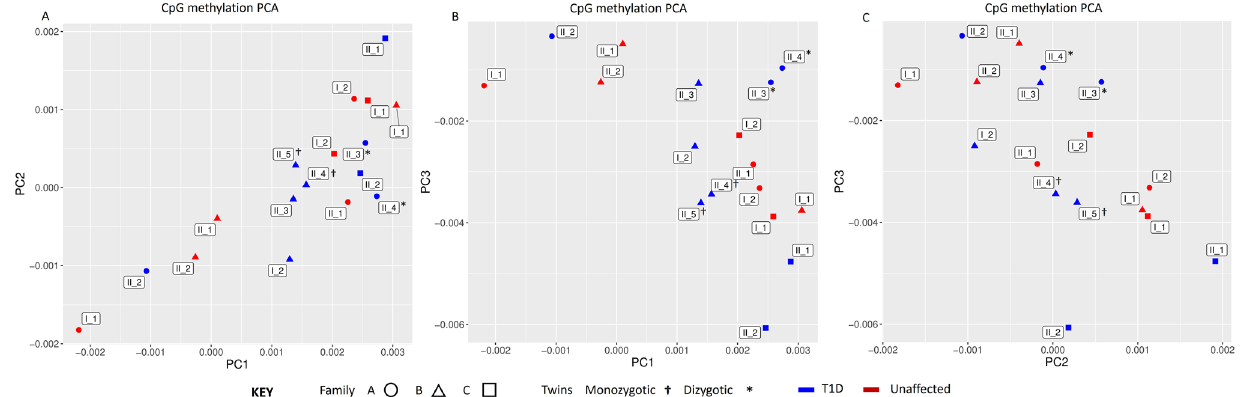
Figure 1. Illustration of inter-individual/family CpG methylome variation observed from PCA plot of the three T1D affected families. ‘I’ refers to parents; ‘II’ refers to children. Blue colour represents T1D individuals while red colour represents unaffected individuals. ( A ) depicts methylome differences observed among samples across the principal components of PC1-PC2; ( B ) depicts across the principal components of PC1-PC3; and ( C ) depicts across the principal components of PC2-PC3. The T1D individuals (in Blue) tend to cluster together, familywise. Similarly, monozygotic (†) and dizygotic (*) twins tend to cluster together suggesting a closer methylome architecture among